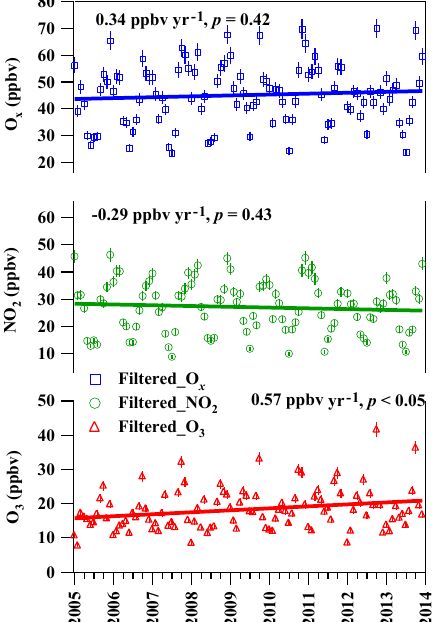
Figure 6. Annual trend of O x , O 3 , and NO 2 (filtered) at TC in the period 2005–2013. Error bars represent the 95% confidence inter- vals of the averages.